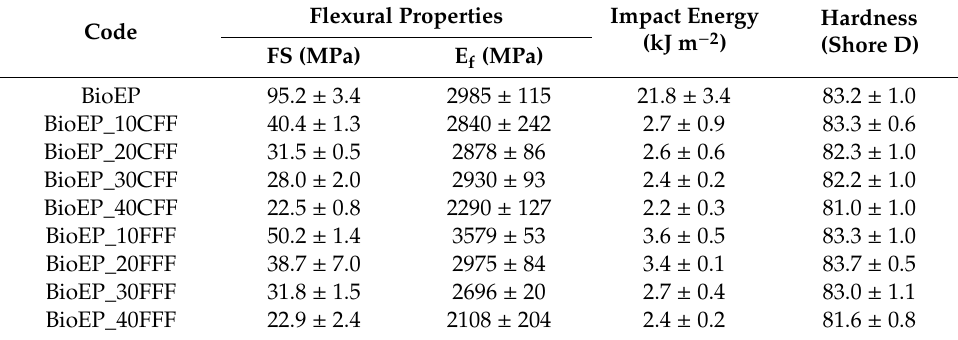
Table 1. Summary of the main mechanical properties of BioEP and BioEP / FF composites reinforced with di ff erent content of coarse (CFF) and fine (FFF) flaxseed flour particles obtained by flexural, impact, and hardness